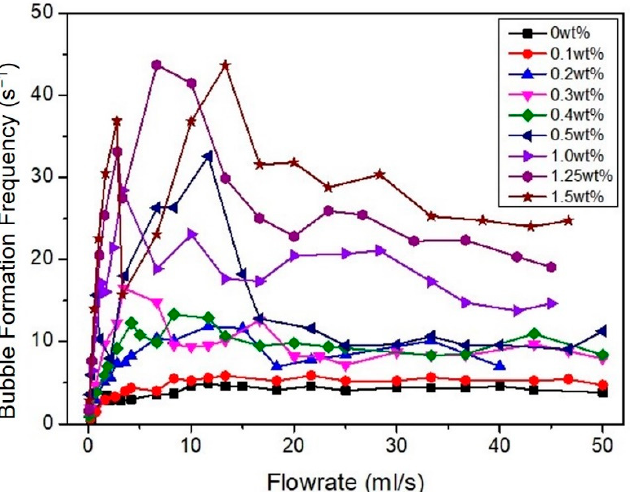
Figure 8. Bubble formation frequency (s − 1 ) at different PEBAX concentrations under different air flow rates.